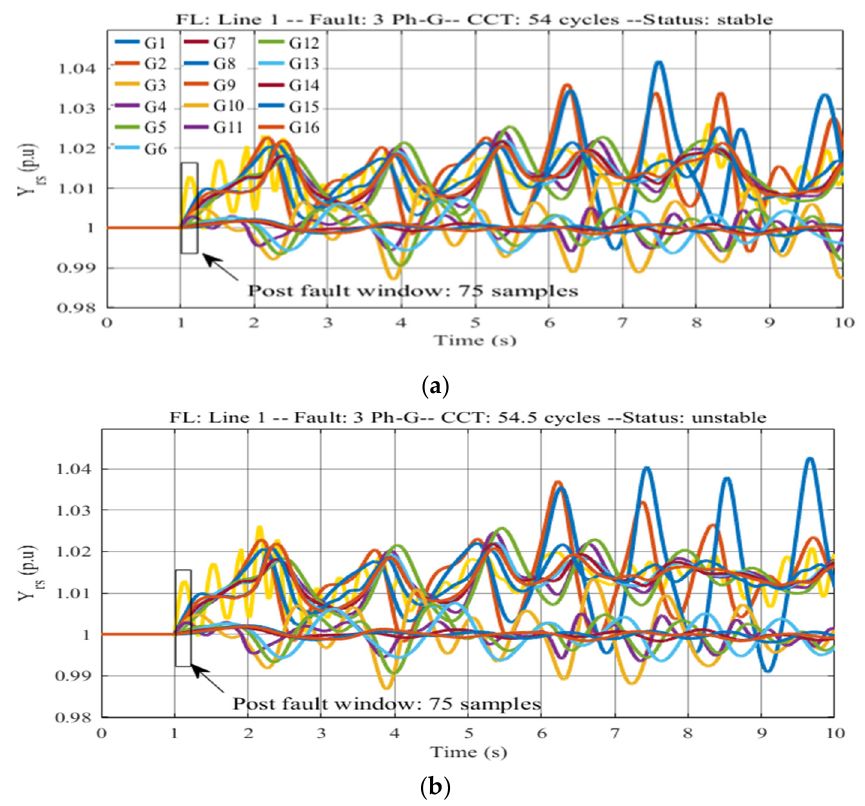
Figure 3. Stable ( a ) and unstable ( b ) rotor speed obtained by simulating three-phase ground fault.